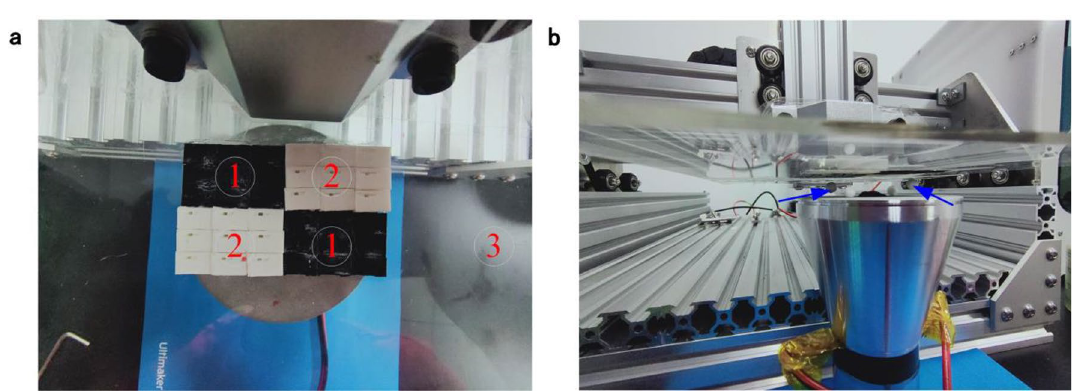
Figure 13. Acoustic resolution experiment. ( a ) Planform of acoustic resolution experiment platform. ( b ) Acoustic